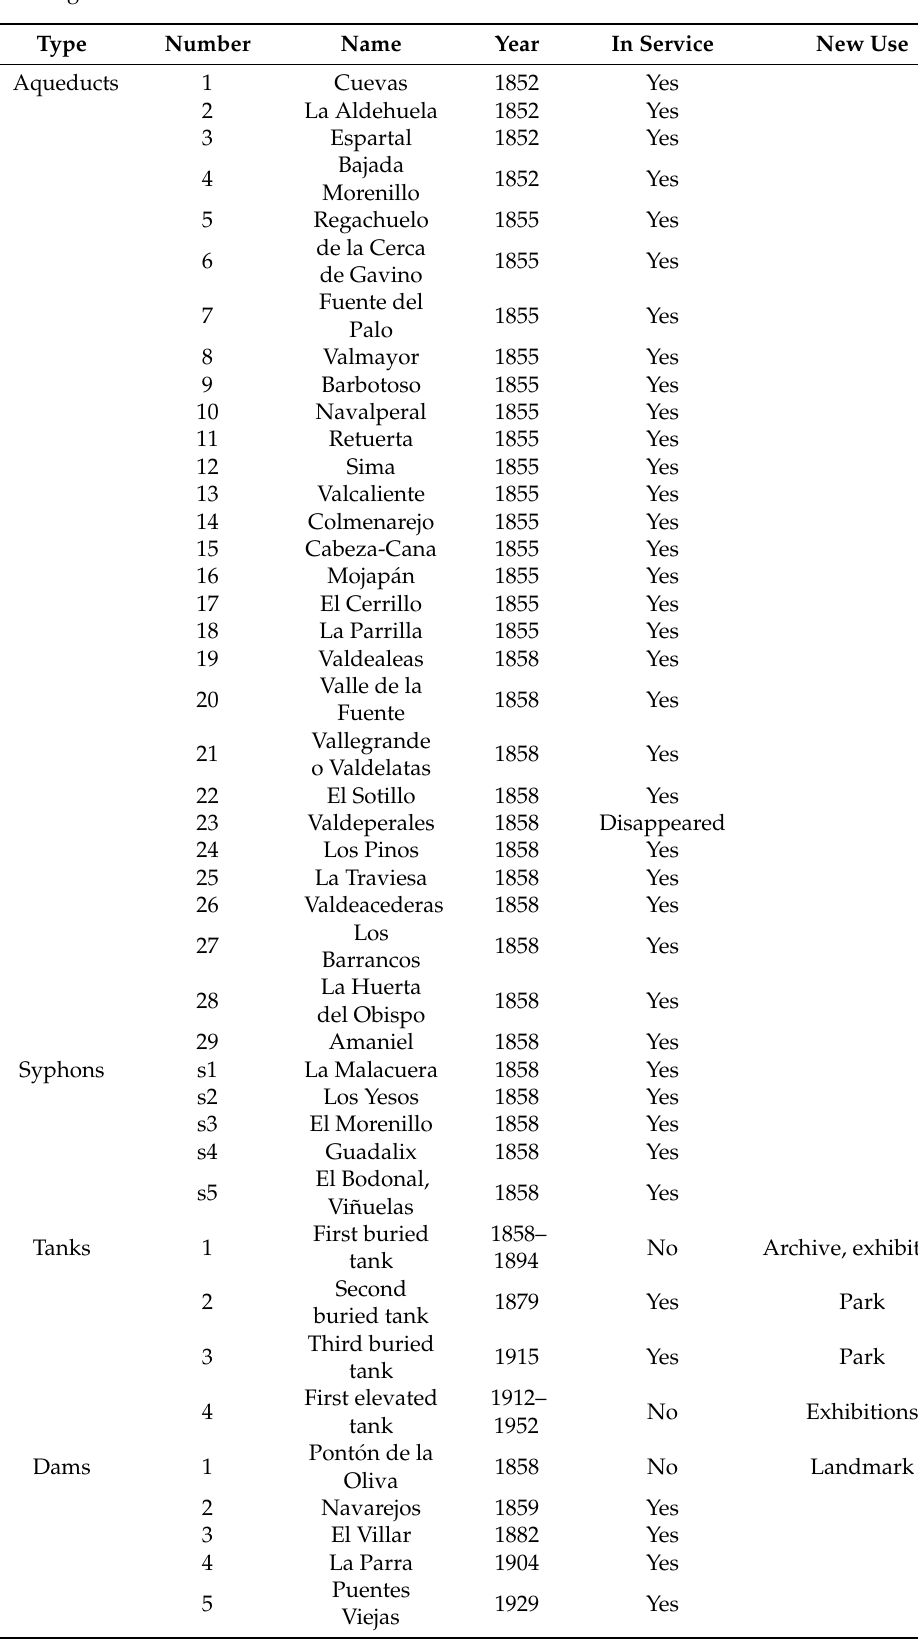
Table 3. Heritage elements of the canal, types and original and current uses. Note the correspondence with Figure